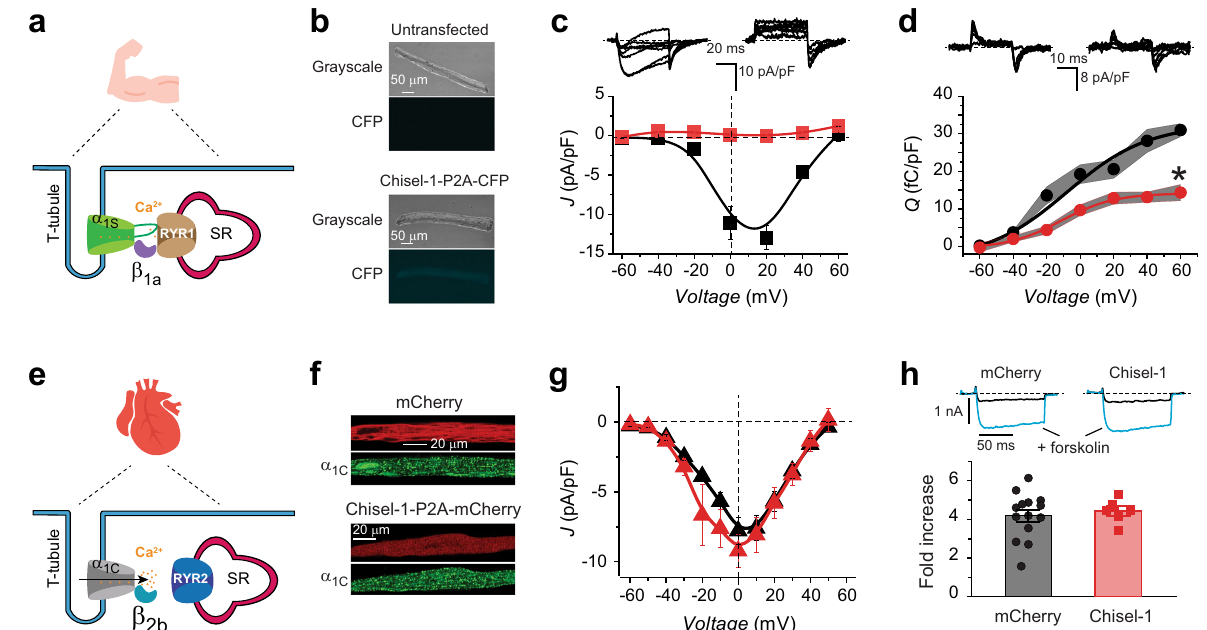
Fig. 8 | Chisel-1 selectively eliminates current through endogenous Ca V β 1 - associated HVACCs. a Schematic of skeletal muscle Cav1.1 complex. b Images of isolated fl exor digitorum brevis (FDB) fi bers either untransfected (top) or trans- fected with Chisel-1-P2A-CFP (bottom). c Top, exemplar whole-cell currents from isolated FDB fi bers expressing CFP (left) or Chisel-1 (right). Bottom, Population J-V curves from isolated FDB fi bers expressing CFP (black squares; n =13 over 3 inde- pendent experiments) or Chisel-1 (red squares; n =13 over 3 independent experi- ments). d Top, exemplar gating currents from isolated FDB fi bers expressing CFP (left) or Chisel-1 (right). Bottom, Population Q-V curves from isolated FDB fi bers expressing CFP (black circles; n =7 over 2 independent experiments) or Chisel-1 (red circles; n =8 over 2 independent experiments). * P =9.32×10 − 5 compared to